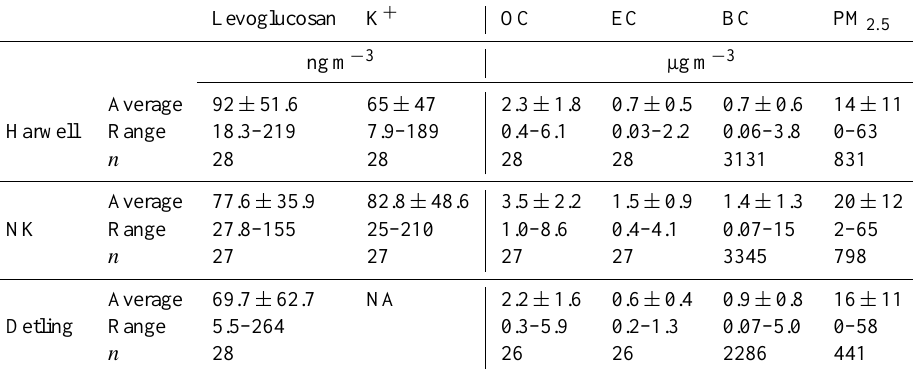
Table 2. Summary statistics for selected species at Harwell, NK and Detling during the winter campaign. BC concentrations from a 2W AE. Variability given for the average is 1 standard deviation. Note NA means not